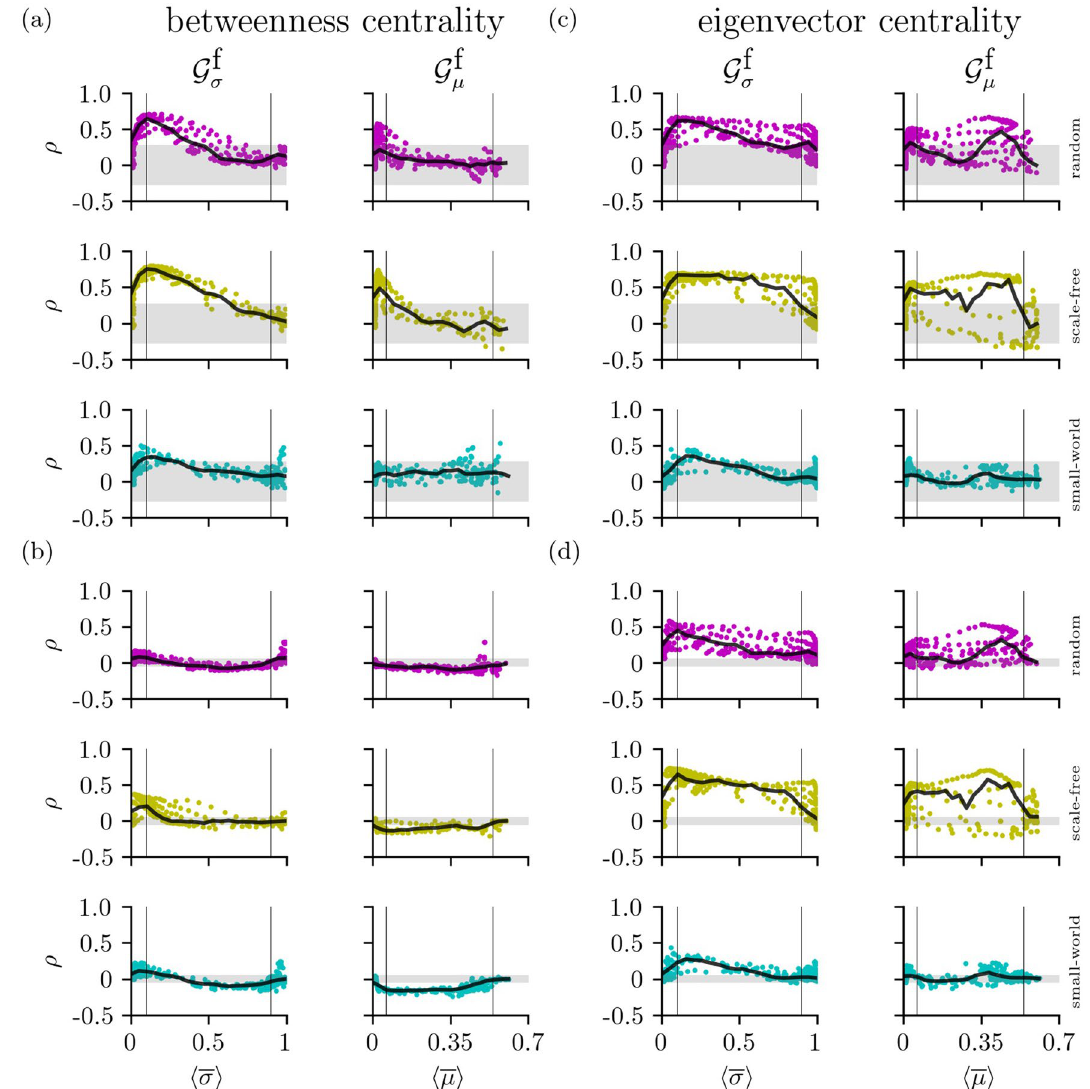
Figure 5. Spearman’s rank correlation coefficient ρ of vertex ( a , c ) resp. edge ( b , d ) centrality values between structural and functional networks depending on average strengths of interaction (derived with either maximum-lag cross correlation σ or mutual information µ ). Rankings are based on either betweenness centrality ( a , b ) or eigenvector centrality ( c , d ). Vertical lines indicate borders between regimes I and II and between regimes II and III, and grey-shaded areas indicate critical values of ρ for a significance level of α = 0.05 (calculated from Student’s t -distribution 93 ). Each data point is an average over 20 realizations with identical control parameter settings and randomized initial conditions near the attractors of the systems. Semi- transparent black lines are moving averages of ρ derived from an equidistant binning of the range of average strength of interactions (20 bins; lines are for eye-guidance